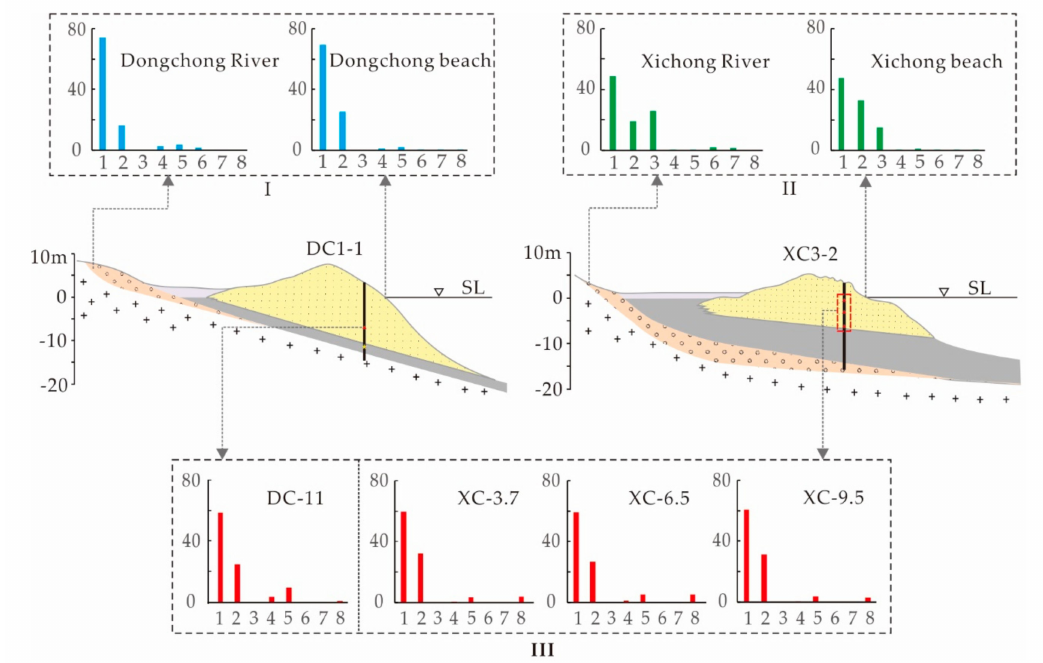
Figure 4. Three di ff erent heavy mineral assemblages in the sediments of ancient beaches, modern beaches and streams at Dongchong and Xichong. 1—Opaque minerals; 2—stable minerals;